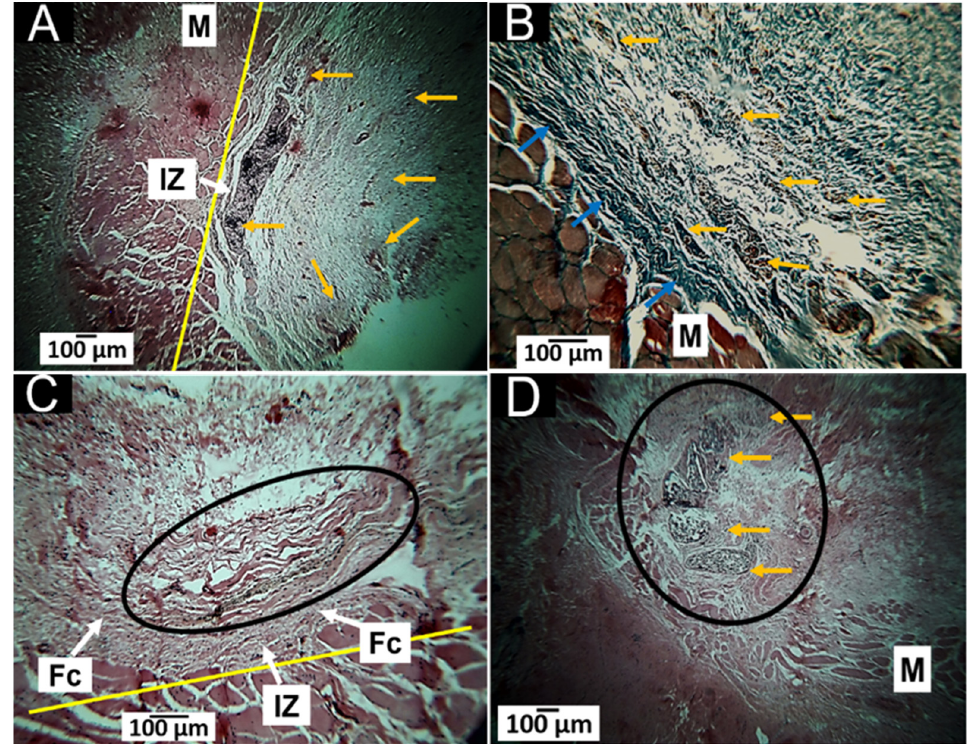
Figure 11. Subdermal implant formulation T5, 100%G. ( A ): Implantation at 30 days, 4× image, H&E technique. ( B ): Implantation at 30 days, the image at 10×, MT technique. ( C ): Implantation at 60 days, the image at 10×, H&E technique. ( D ): Implantation at 60 days, 4× image, HE technique. M: muscle. IZ: implantation zone. IC: inflammatory cells. Yellow arrow: fragments of the biomaterial. Blue arrows: connective tissue (type I collagen). Oval and circle: fragments of the material in the implantation area.